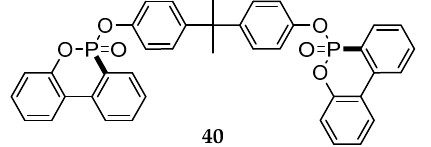
Figure 17. Chemical structure of bisphosphonate 40 .